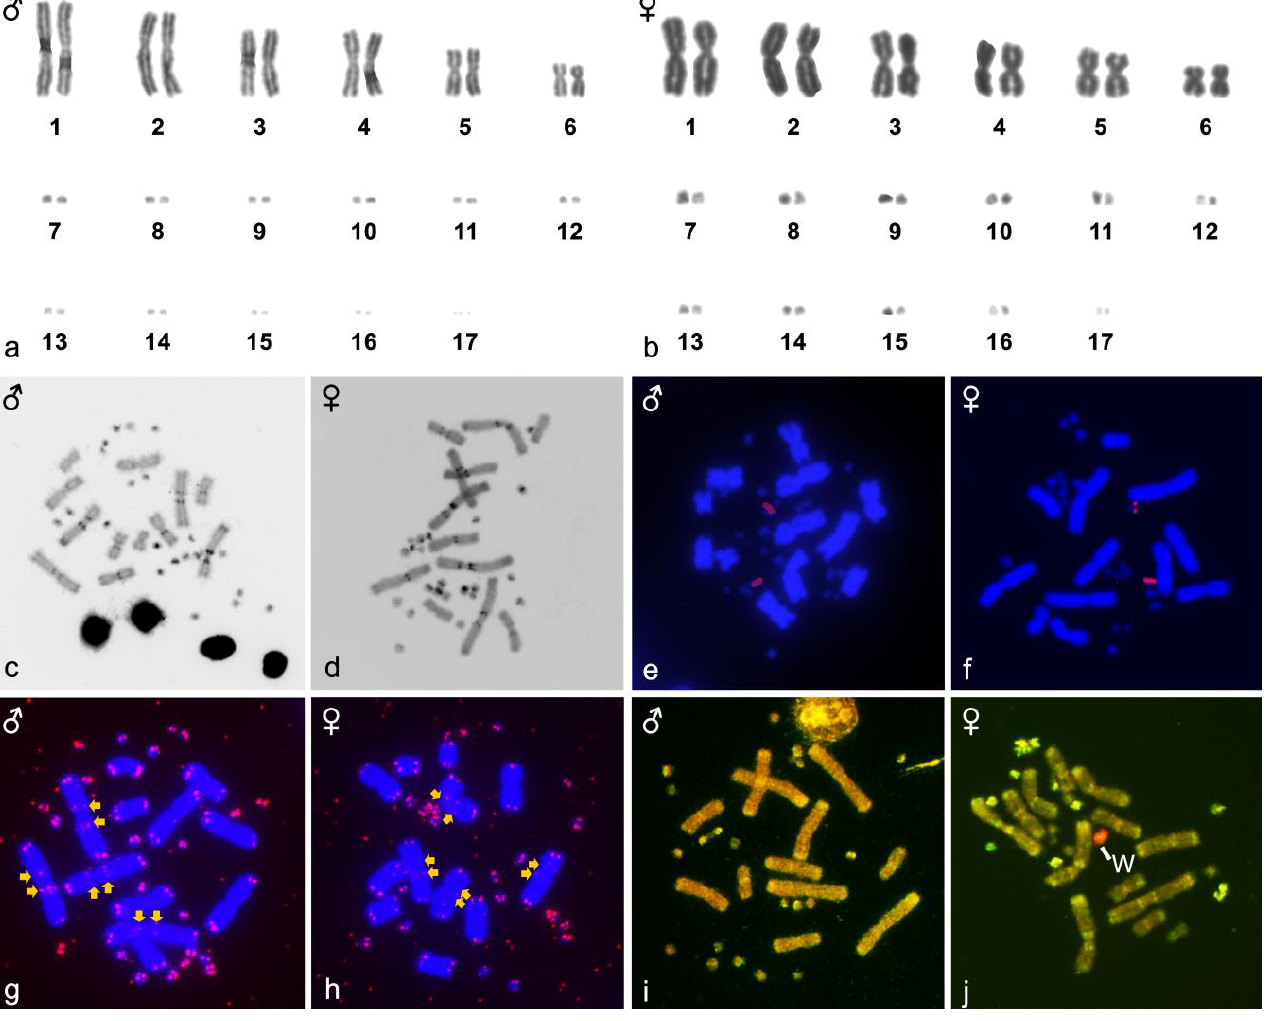
Figure 1. Giemsa-stained karyograms ( a , b ), C-banding ( c , d ), rDNA loci ( e , f ), telomeric motifs ( g , h ) and comparative genomic hybridization ( i , j ) in metaphases of a male and a female Z. madagascariensis . The W chromosome is indicated in CGH. ITRs are indicated by yellow arrows.